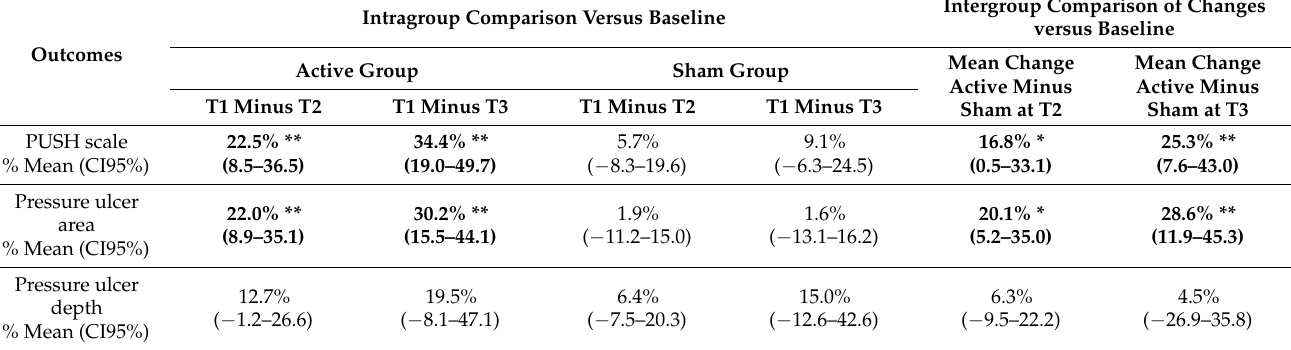
Table 2. Results of variables related to the healing of pressure ulcers: intragroup and intergroup comparison of changes versus